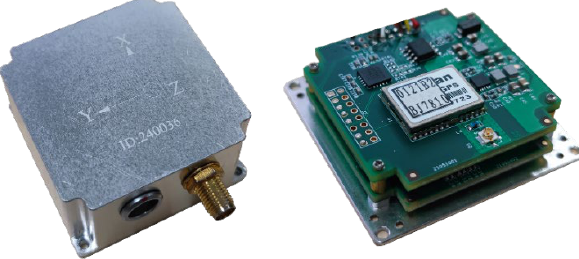
Figure 5. External and internal structure of physical design.